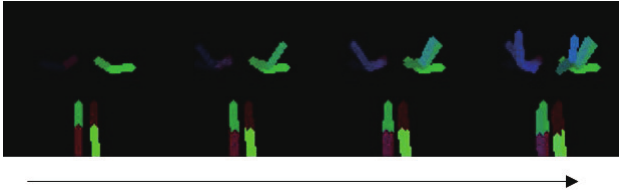
Figure 6. An example of an action